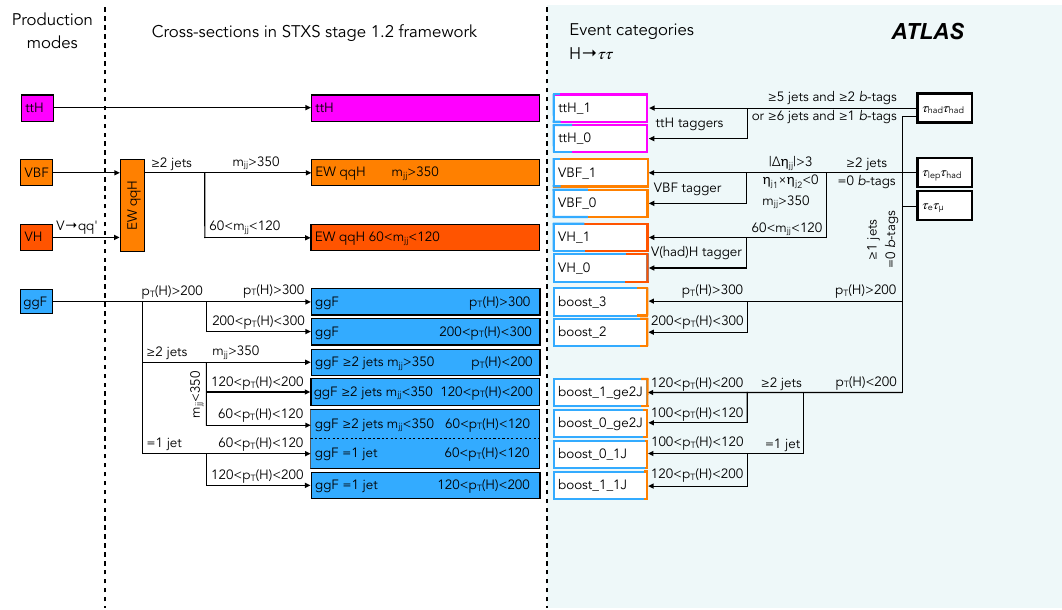
Figure 1. Sketch of the event categorisation and the targeted cross-sections in the STXS stage 1.2 framework (bins). The relative contributions to each event category from the two most dominant STXS bins are indicated by the two colours used along the width of the category box. The requirements on p ( H ) and m are given in units of T jj